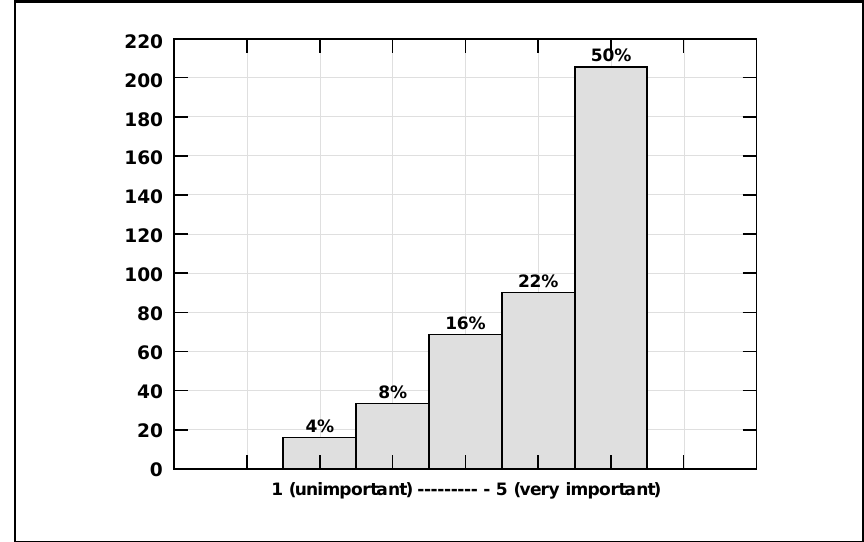
Figure 2: Importance rating for inclusion of pharmacology at under- graduate level.